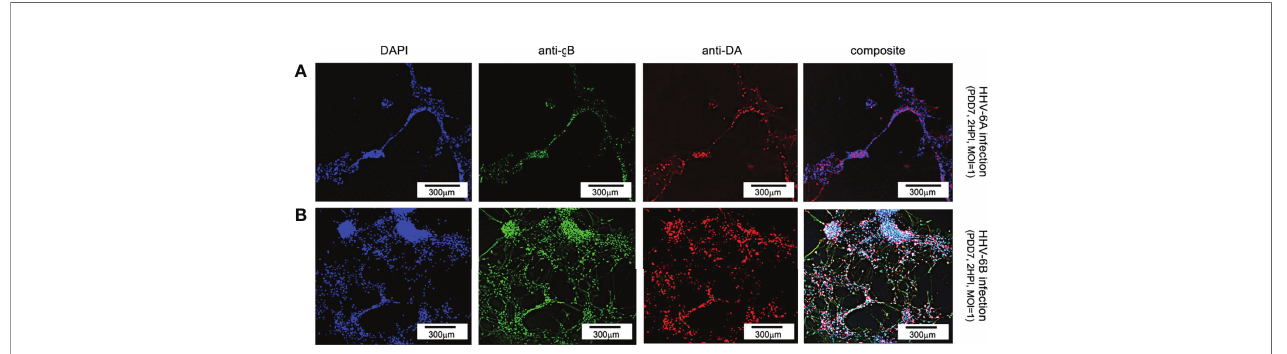
FIGURE 7 | Fluorescence microscopy images of dHNSC treated with immuno fl uorescent antibodies and fl uoro-dye (DAPI) at PDD7: Dopaminergic neurons. DA- positive dHNSC at PDD7 (2HPI, MOI = 1) shown (left to right) by DAPI staining and antigB and anti-DA immuno fl uorescence (with composites) indicate that gB (green) colocalizes with dopamine (red) in DAPI stained (blue) cells for both HHV-6A (row A ) and HHV-6B (row B ) infected cultures, suggesting susceptibility of dopaminergic neurons to both viruses (Results were consistent across 6 replicate trials). [Scale bar =